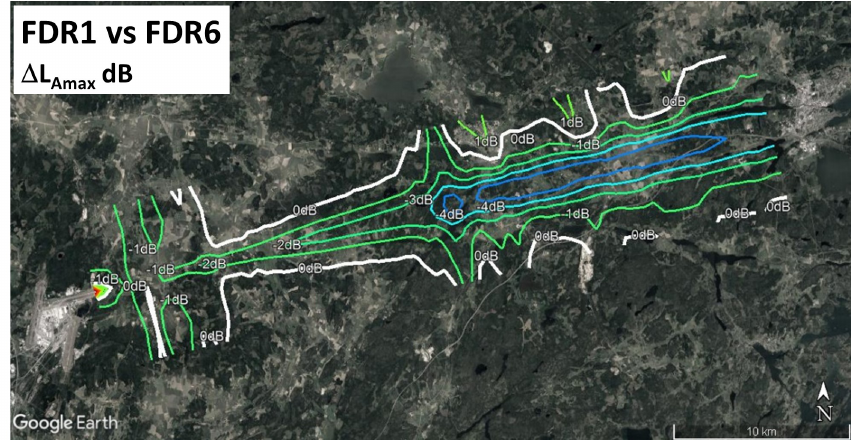
Figure 16. Noise prediction difference of FDR1 with respect to FDR6 using SAFT ECAC Doc 29